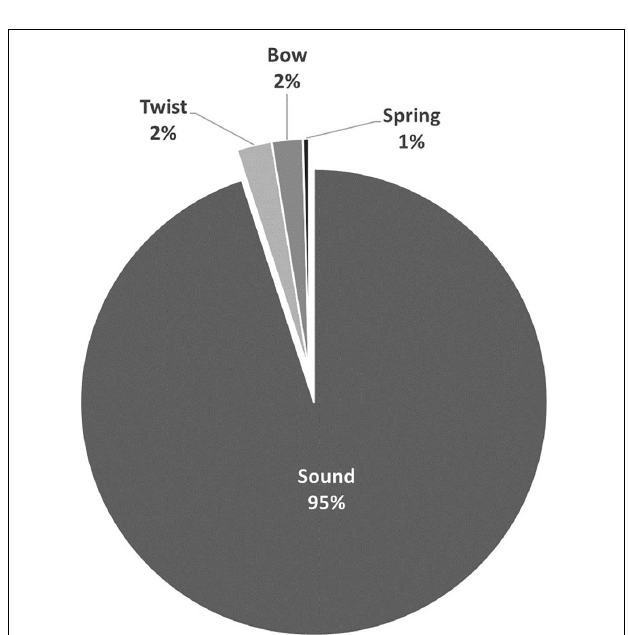
FIGURE 7 | Distribution of the different deformation types of the evaluated Beech sleepers ( n =